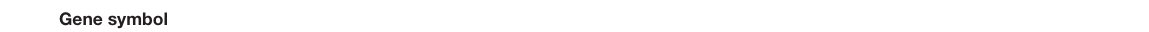
TABLE 1 | The consensual DEGs were identified in GSE150819.